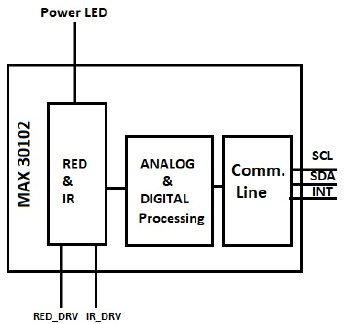
Figure 5. MAX30102: Functional Diagram